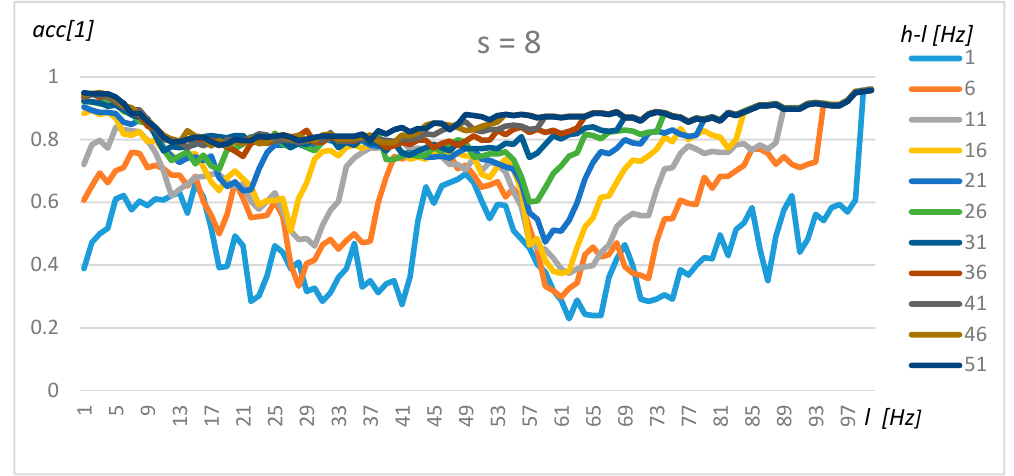
Figure 12. Exhaustive tuning method for resolution 1 Hz.